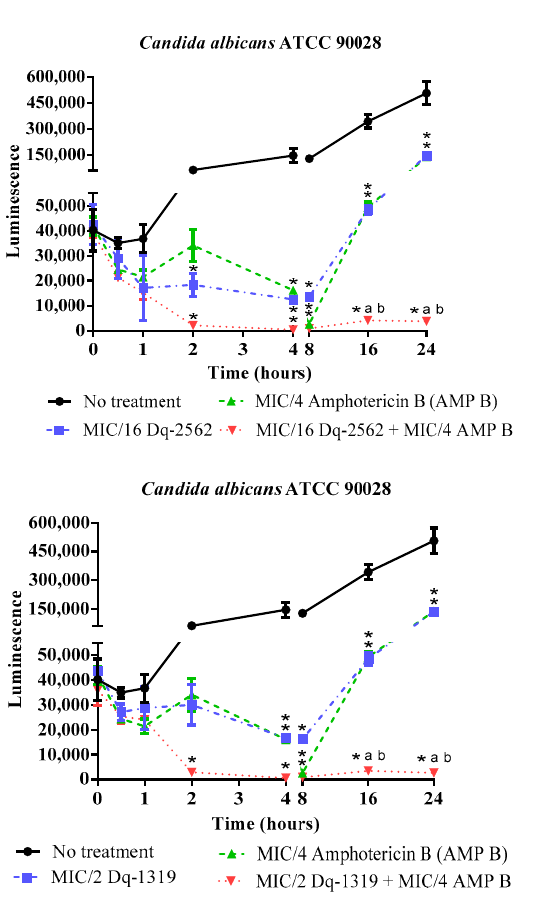
Figure 3. Time-kill effect of D. quadriceps antimicrobial peptides in combinations with amphotericin B on the cell viability of Candida albicans ATCC 90028. ANOVA and Tukey’s multiple comparisons test. * p < 0.05 (compared to untreated Candida cells). a : p < 0.05 (compared to subinhibitory concentrations of individual peptides alone). b p < 0.05 (compared to subinhibitory concentration of amphotericin B, AMP B).